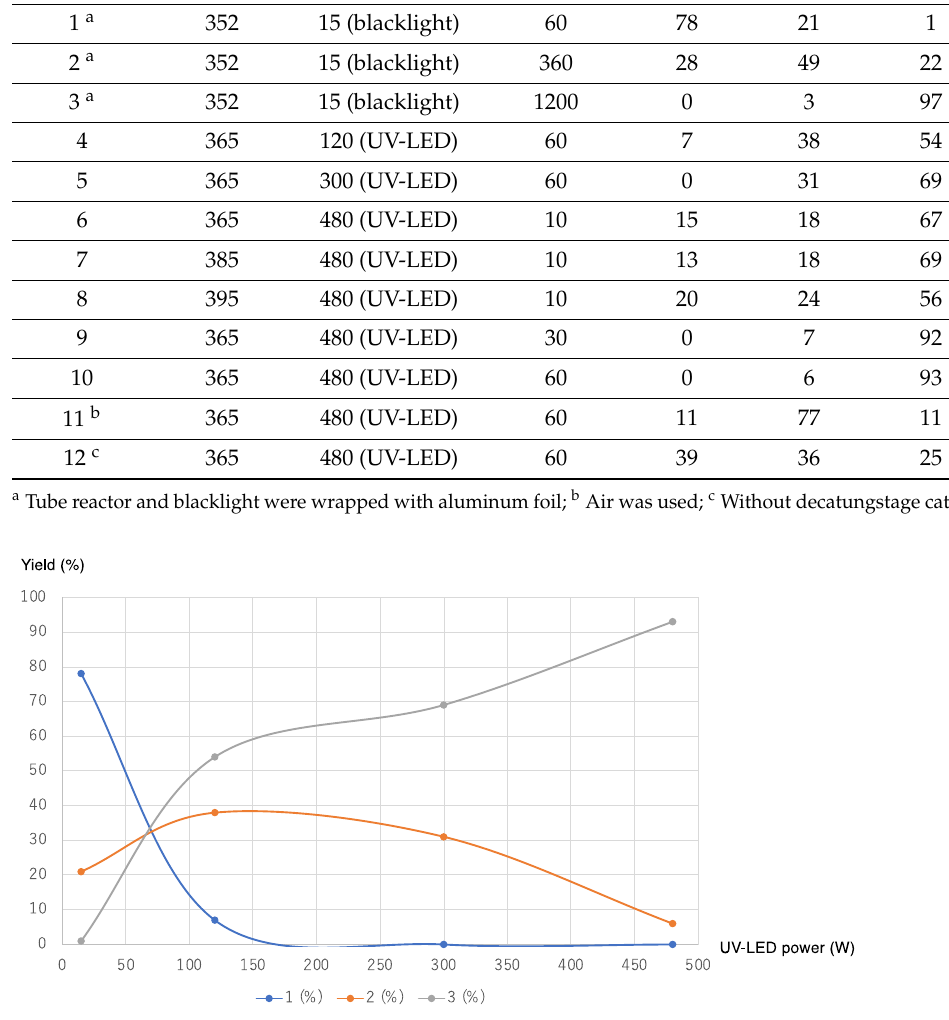
Figure 3. Effect of irradiation power for a 1 h reaction of 1 with O 2 .